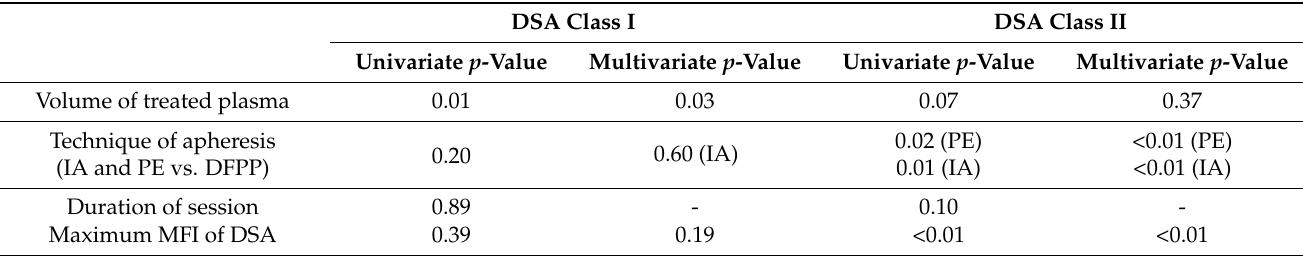
Inter-session analyses: For class I DSAs, the mean decrease in MFI was 88 ± 50%. In univariate and multivariate analyses, the volume of treated plasma and the IA were associated with a higher inter-session DSA decrease, p = 0.04 and p = 0.03, respectively. For class II DSAs, the mean decrease in MFI was 59 ± 34%. In univariate and multivariate analyses, a higher total volume of treated plasma was significantly associated with a decrease in inter-session MFI ( p = 0.02) (Table